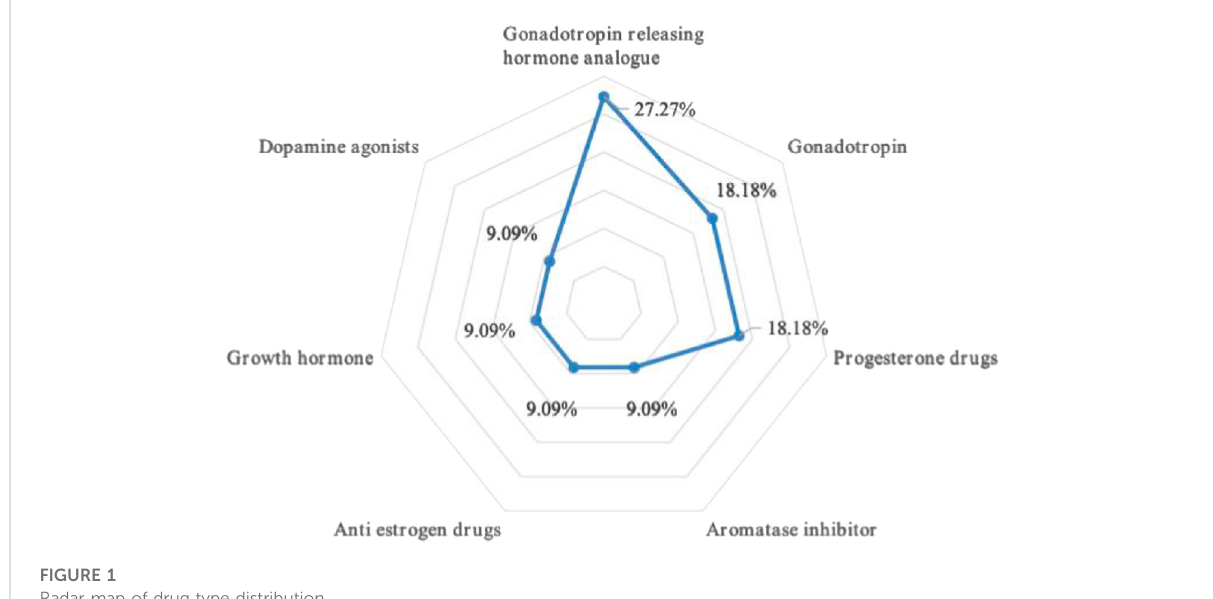
FIGURE 1 Radar map of drug type distribution.